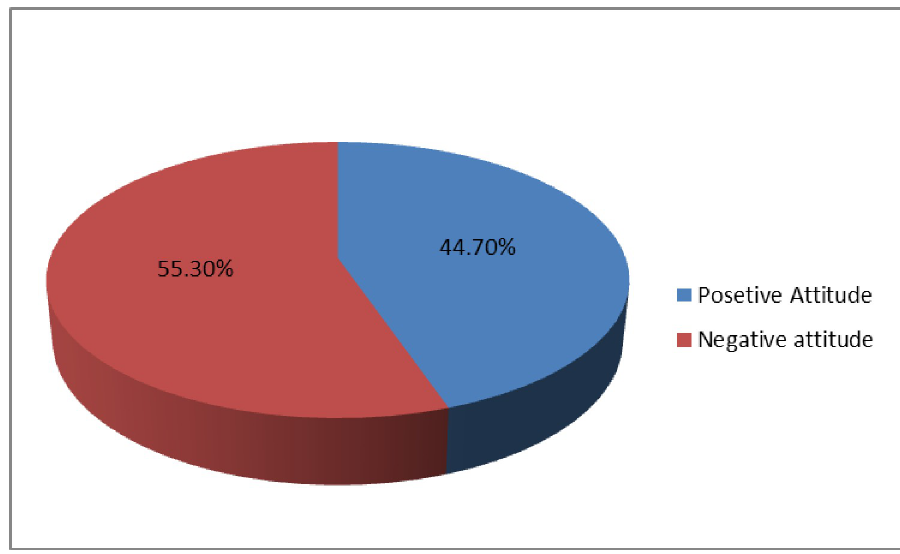
Fig 2. Attitude toward receiving the 2021 COVID-19 vaccine from the Gurage